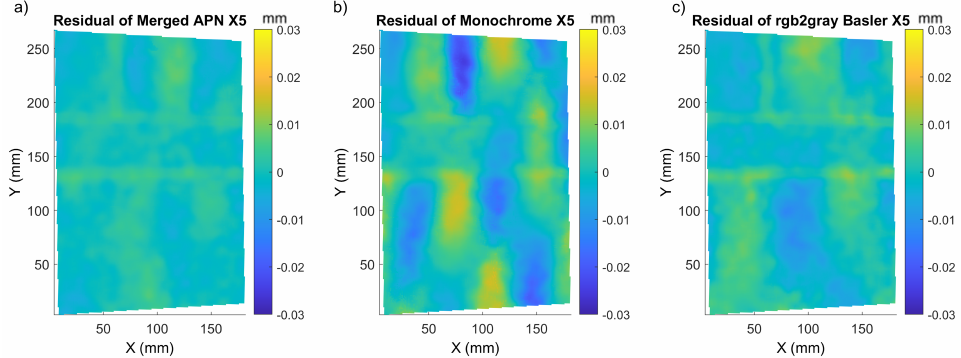
Figure 9. X5 residual displacement maps of Mock-up , for: ( a ) merged APN, ( b ) Monochrome and ( c ) Basler converted to